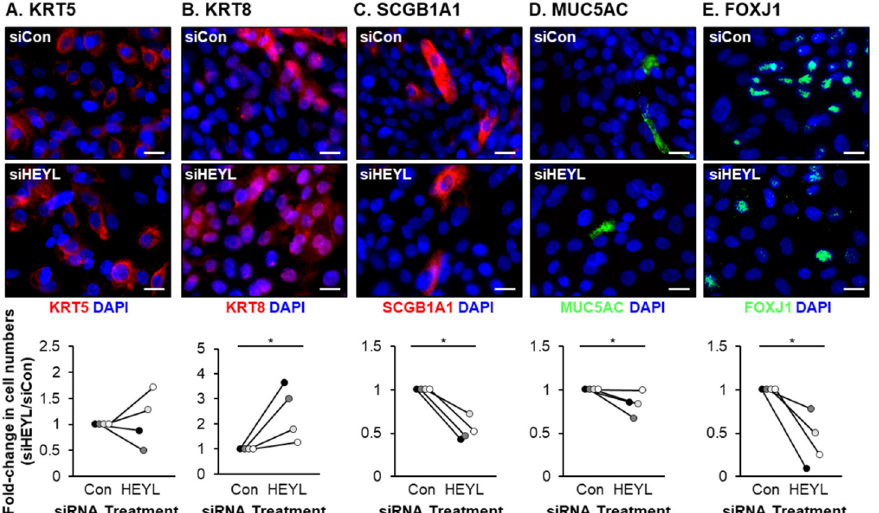
Figure 5. siRNA-mediated knockdown of HEYL suppresses club, goblet and ciliated cell differentiation. HBECs ( n = 4 normal, nonsmoker donors) were transfected with either control (siCon) or HEYL (siHEYL) specific siRNA during seeding on ALI culture. On ALI day 7 the cells were harvested for immunofluorescent staining and quantification of ( A ) basal cells (KRT5, red), ( B ) intermediate cells (KRT8, red), ( C ) club cells (SCGB1A1, red), ( D ) goblet cells (MUC5AC, green) and ( E ) ciliated cells (FOXJ1). Nuclei are stained blue with DAPI. For each donor, the data are presented as fold-change in cell numbers compared to siCon cells. Scale bar = 20 µ m. * p <